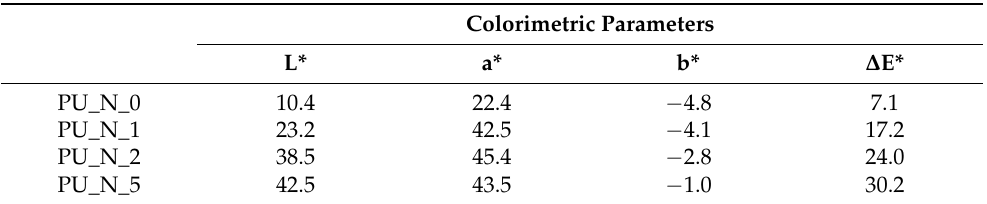
Table 6. Color analysis of PU foams before UV aging, where ∆ E*—total color change, L*—degree of lightness, a*—red/green parameter, b*—yellow/blue parameter.